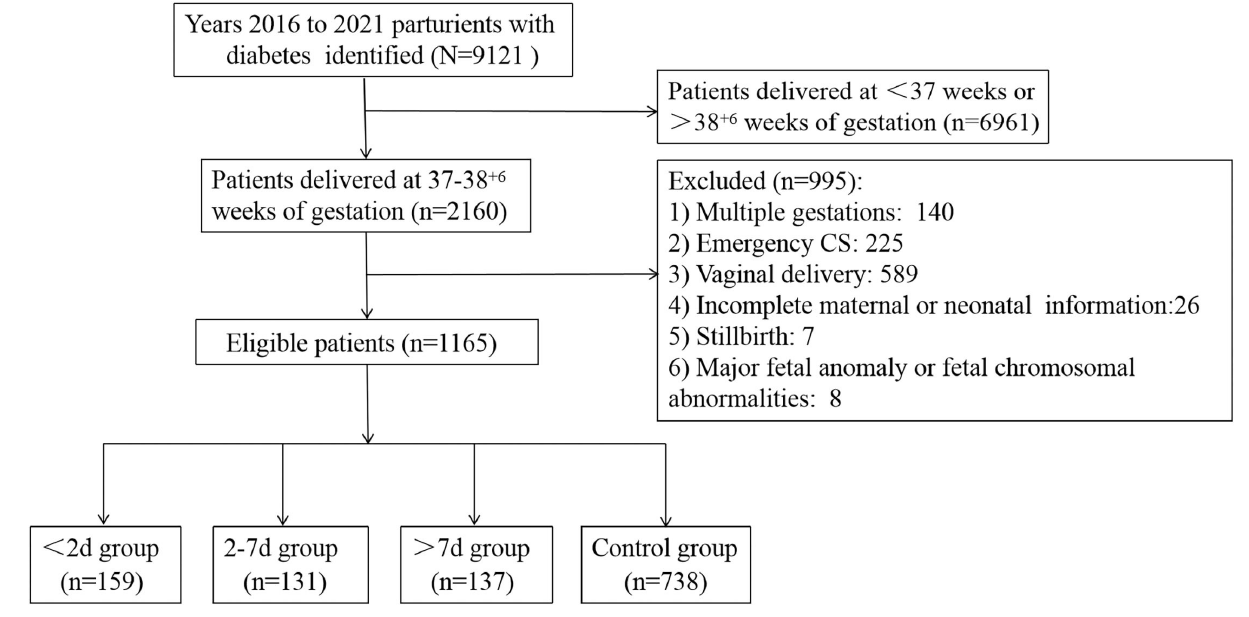
FIGURE 1 | Flow chart of included